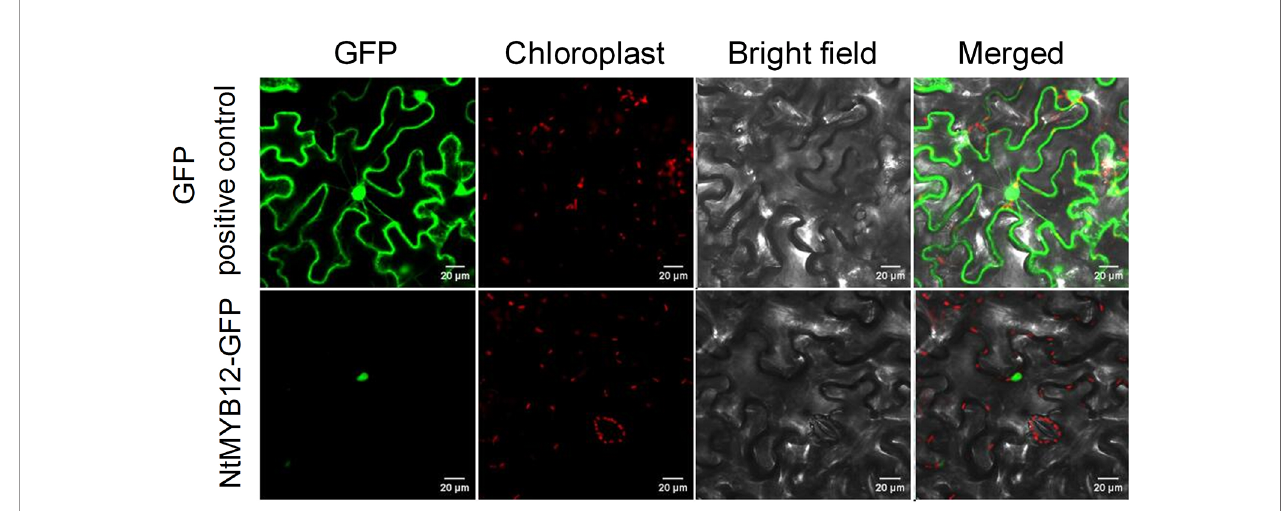
FIGURE 2 | Sub-cellular localization of NtMYB12 in tobacco epidermal cells. The fusion protein ( NtMYB12 -GFP) and GFP-positive control were independently transiently expressed in tobacco cells. GFP fl uorescence was observed with a fl uorescence